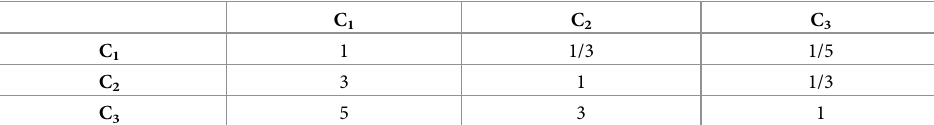
Table 14. Pair-wise comparisons of the first level factors in the emergency response 2.